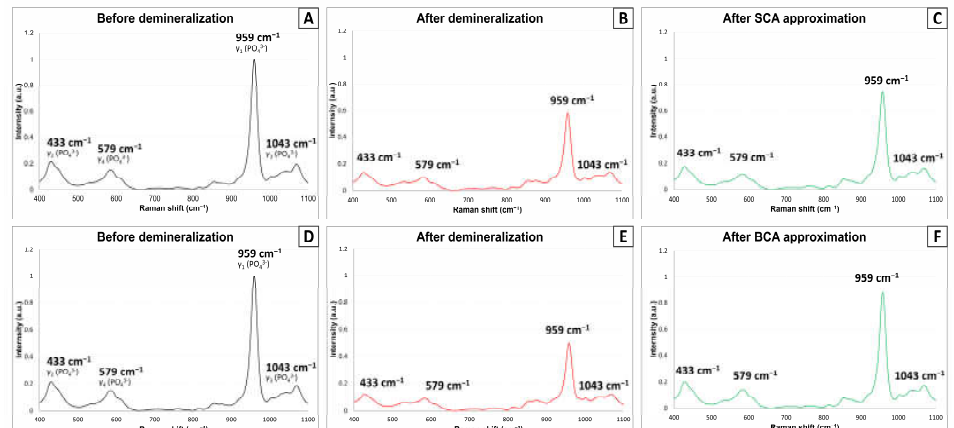
Figure 5. Confocal Raman spectra of the SCA and BCA group. ( A – C ) Raman spectra of the SCA group (before, after demineralization, and after SCA approximation, respectively). ( D – F ) Raman spectra of the BCA group (before, after demineralization, and after BCA approximation, respectively). Abbreviations: SCA, silica-containing adhesive; BCA, BAG-containing adhesive.